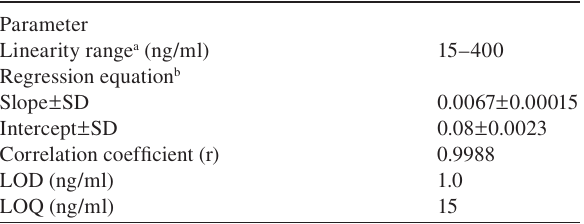
Results of analytical parameters for proposed methods.